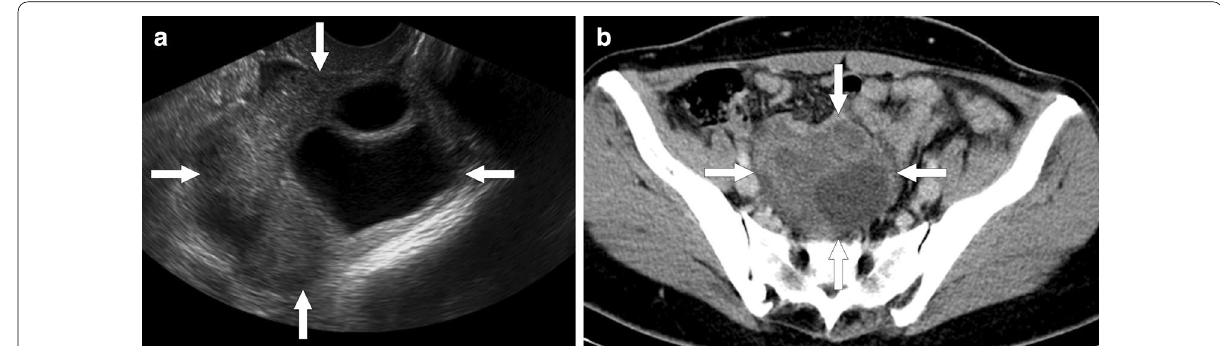
Fig. 30 Chronic ovarian torsion. A 42-year-old female patient with no significant past medical history presenting with progressively increasing blunt pelvic pain in the last two months. a US study demonstrated 6 cm mostly solid appearing mass (with central and peripheral cystic areas) (arrows) within the right adnexa. Axial plane postcontrast CT scan b confirmed the presence of the sonographically detected mass (arrows). Postsurgical pathological examination showed no evidence of malignant disease but confirmed chronic ovarian torsion